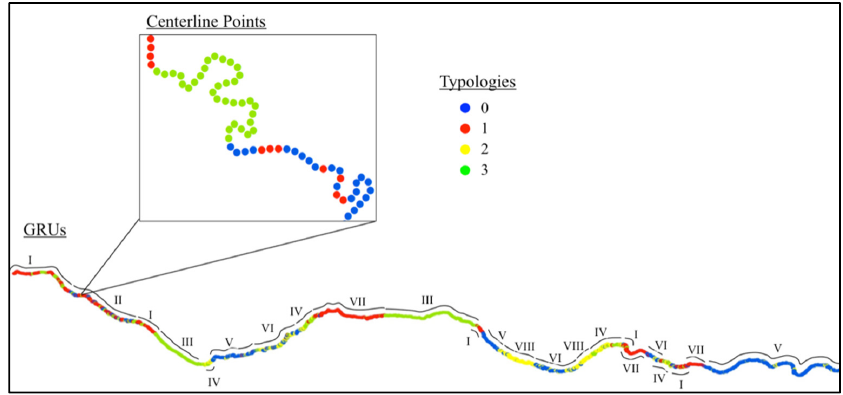
Figure 3. Colour-coordinated centerline points and corresponding typology, with resultant GRUs. River typologies were each given an identifying color and assigned to the corresponding 50-meter centerline points. Patterns within the typology distribution were visually assessed to identify spatial groupings (GRUs); eight different GRUs were identified along the Qu’Appelle River (Figure 3). An example of repetitive typology patterns being identified as a GRU occurs in GRU I, which is composed of Typology 1 and 3, as compared to GRU II that is a mix of typologies 0, 1 and 3 (Figure 3). As the objective of this study is to identify geomorphologically similar reaches along the